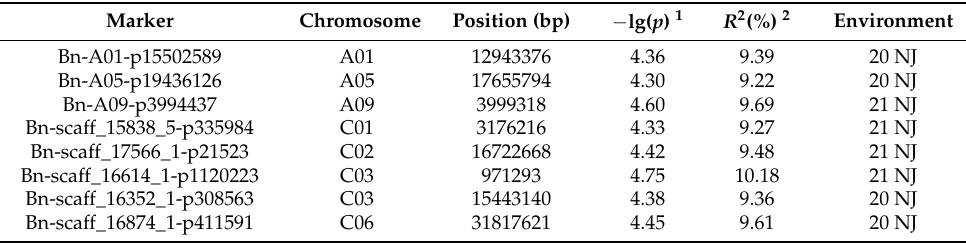
Table 3. Significant genome-wide association study single-nucleotide polymorphisms of soluble solids content in mixed linear